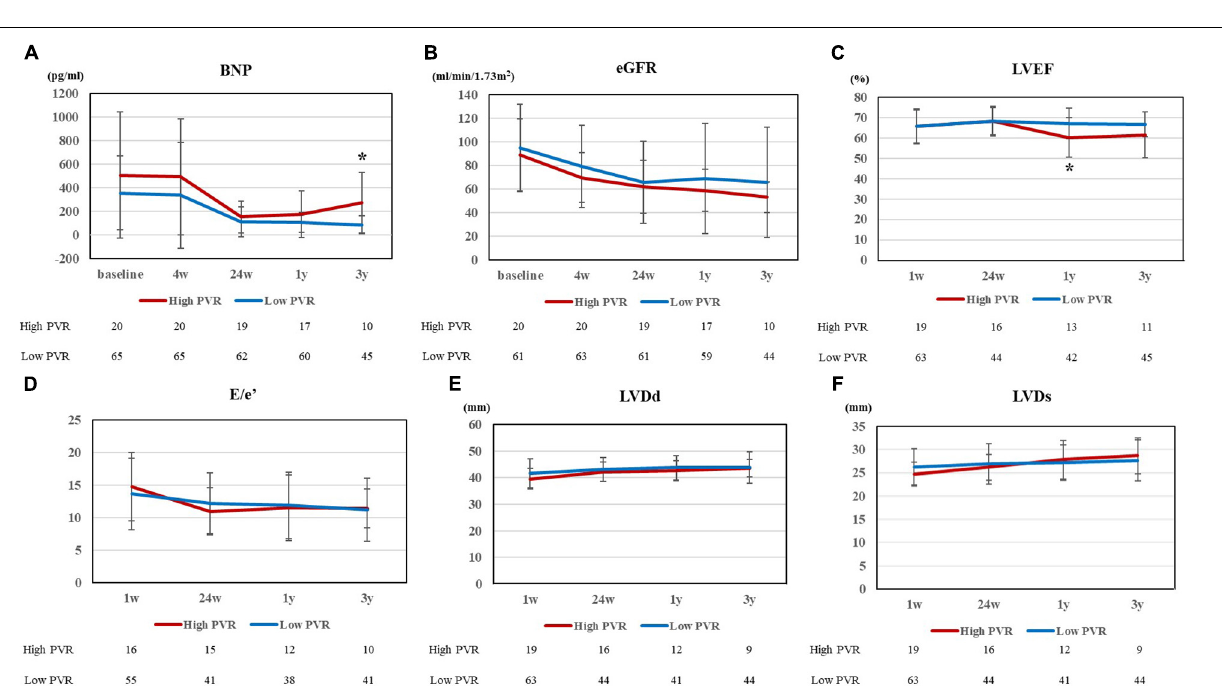
Frontiers in Cardiovascular Medicine |